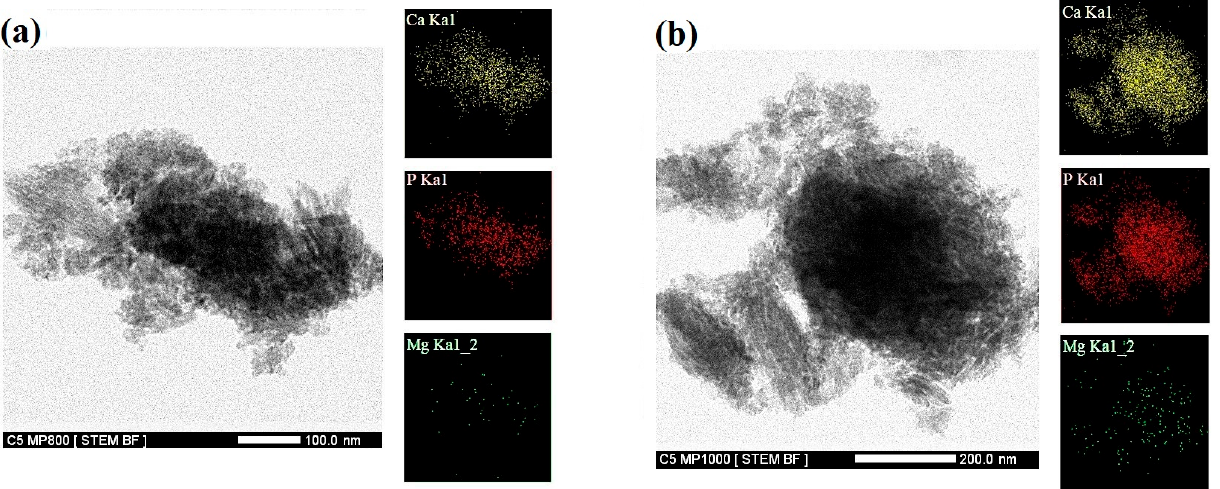
Figure 7. STEM/EDX analysis (mapping) of elements in C1MP850 ( a ), C1MP1000 ( b ).